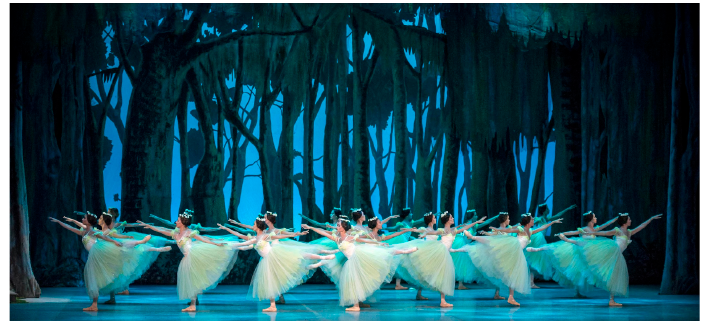
Figure 1. Giselle , Act 2. National Ballet of Cuba. [image is used from https://balletcuba.cult.cu/ (accessed on 12 April 2023).